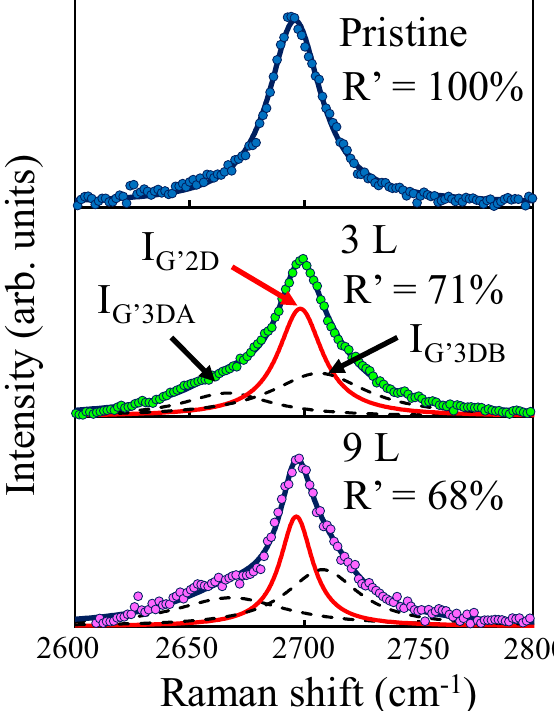
Figure 2. Raman spectra in the 2D-band region observed from the pristine monolayer and grown multilayer GNR. The dotted circles and thin solid lines are the experimental data and fitting curves, respectively.